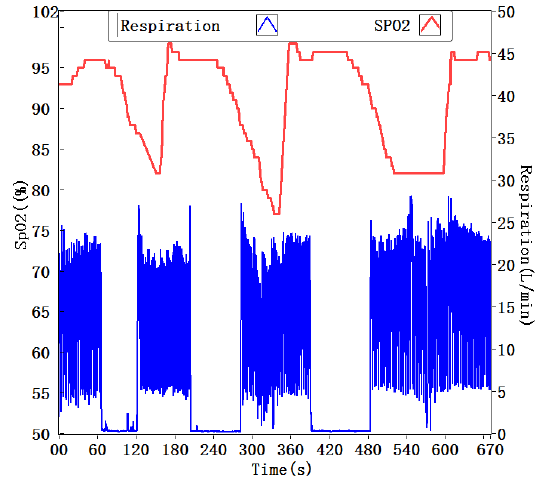
Figure 14. Monitoring of SpO 2 and respiration.